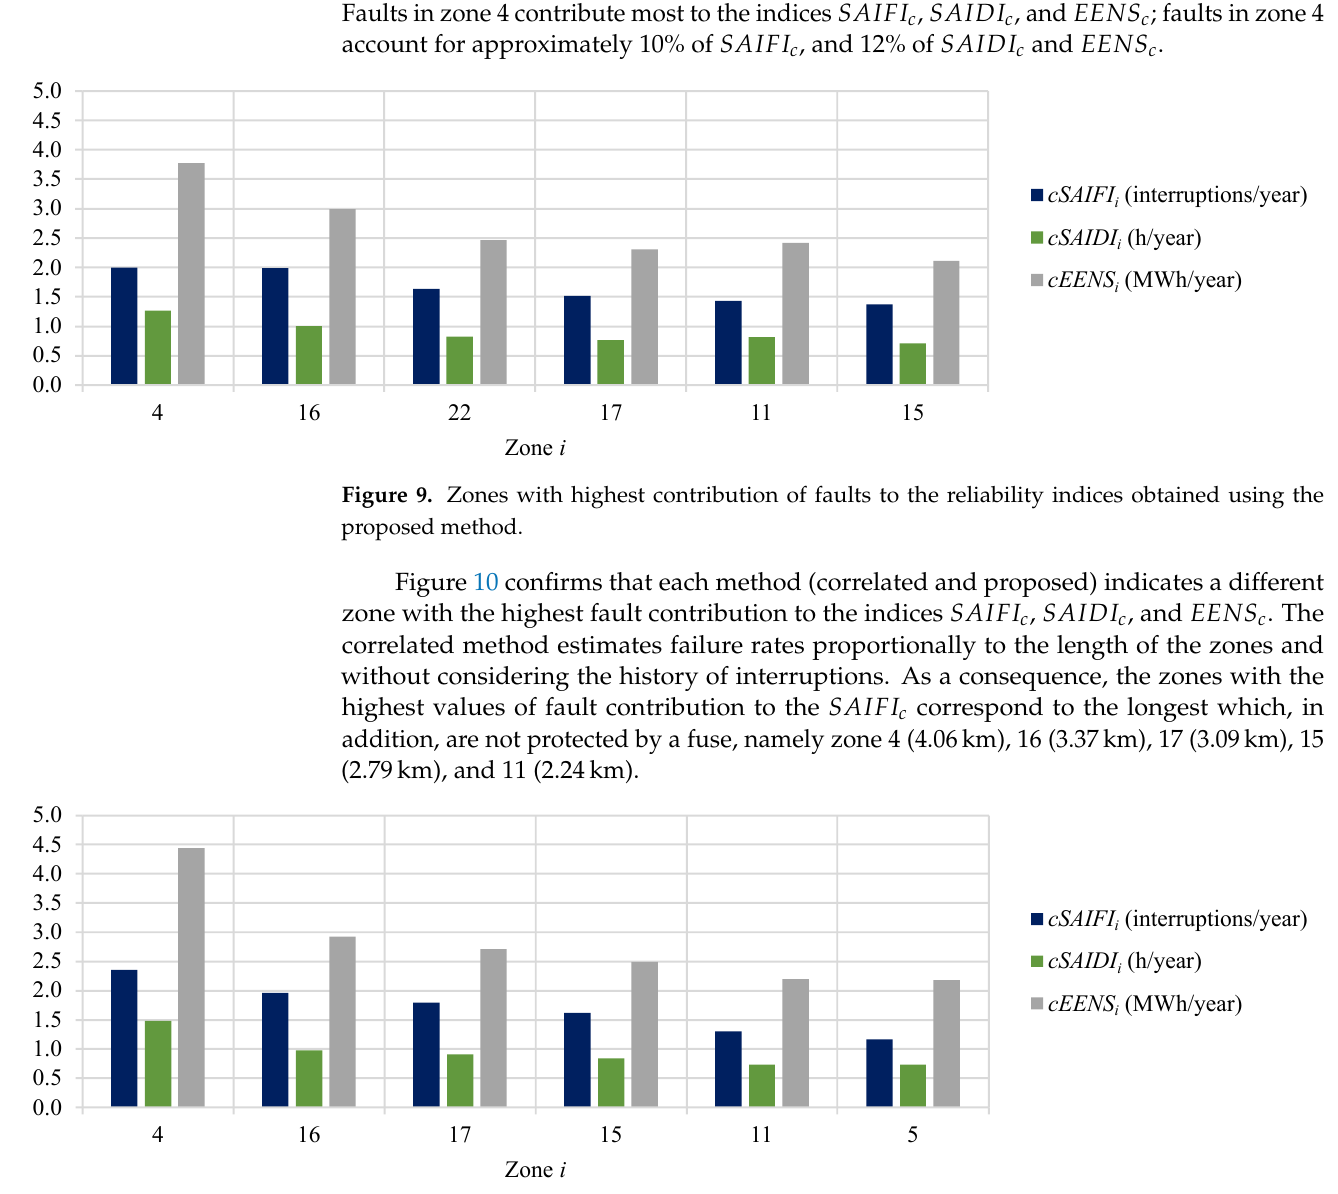
Figure 10. Zones with highest contribution of faults to the reliability indices obtained through the correlated